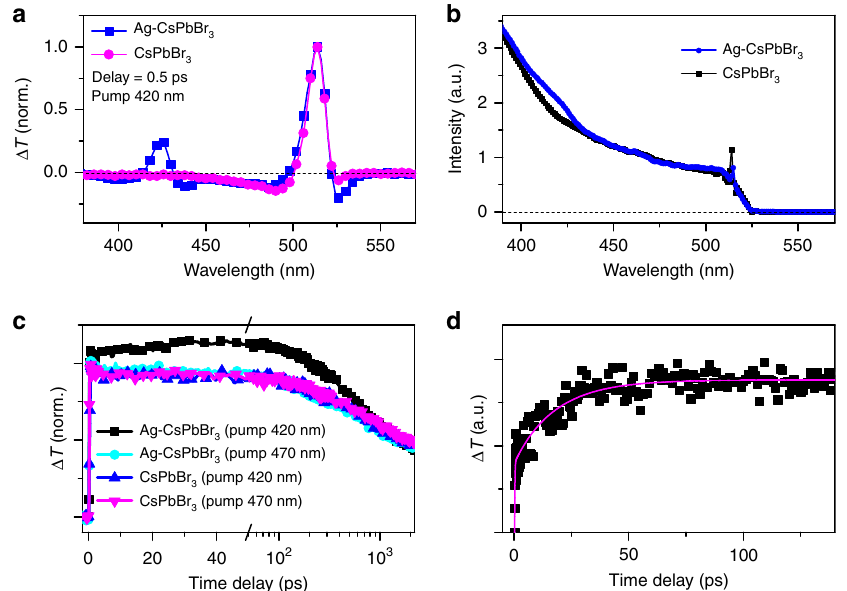
Fig. 4 Hot-electron transfer (HET) dynamics in Ag – CsPbBr 3 nanocrystals (NCs). a TA spectra normalized to the signal amplitude at 514 nm recorded at a time delay of ~0.5 ps from CsPbBr 3 and Ag – CsPbBr 3 NCs, respectively. The pump wavelength is 420 nm. b PL excitation spectra recorded from CsPbBr 3 and Ag – CsPbBr 3 NCs. The spectra are normalized to the PL intensity under 470 nm excitation. c Kinetic curves probed at 514 nm recorded from CsPbBr 3 and Ag – CsPbBr 3 NCs pumped at the wavelengths of 420 and 470 nm, respectively. The curves are plotted normalized to the signal amplitude recorded at a delay of 2 ns. d Scaled kinetics of carrier transfer from Ag to CsPbBr 3 NCs in hybrid NCs obtained by subtracting the contribution of CsPbBr 3 from that of Ag – CsPbBr 3 NCs, whereas the signals for the two samples are normalized to the amplitude at a time delay of 2 ns. The solid line is the curve fi tted to